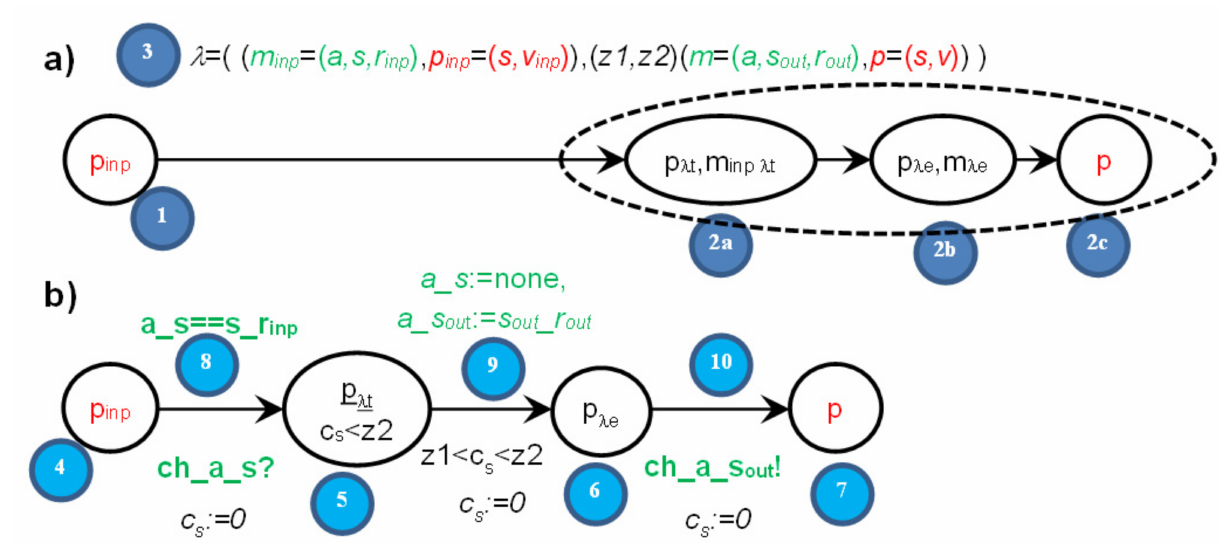
Figure 4. ( a ) action of IMDS with time durations between z1 and z2 ( b ) translation to Uppaal TA. For Uppaal TA: underlined font in location—time invariant of location, regular font in location—location name, regular font in transition label—time constraints of transition, italic font —update executed on transition, bold font —Boolean condition enabling transition or